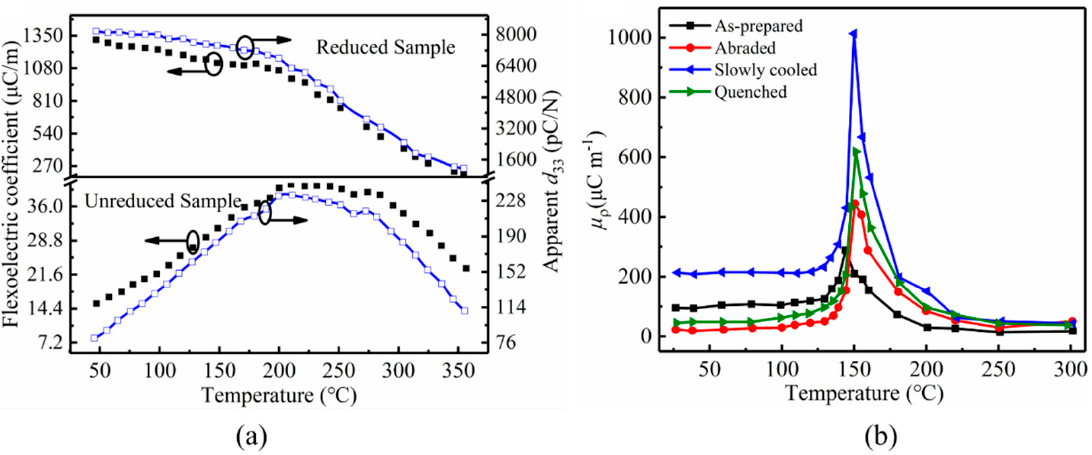
Figure 9. ( a ) The temperature dependence of the flexoelectric coefficient and apparent d 33 for reduced and unreduced NBBT8 ceramics under bending. Reprinted with permission from [60]. Copyright 2018 Elsevier. ( b ) The temperature dependence of the flexoelectric coefficient for BaTiO 3 ceramics under bending. Reprinted with permission from [45]. Copyright 2018 American Physical Society.